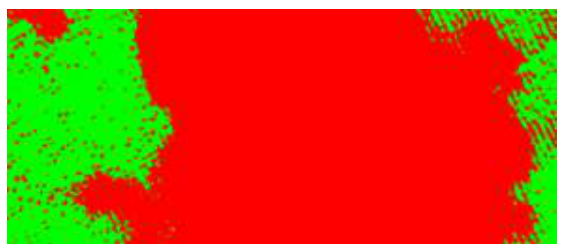
Figure 7. The classification results of two bands of the LRcube where red are pixels of shadows which include plant shadows and cloud shadows while green represents pixels of the non- shadow